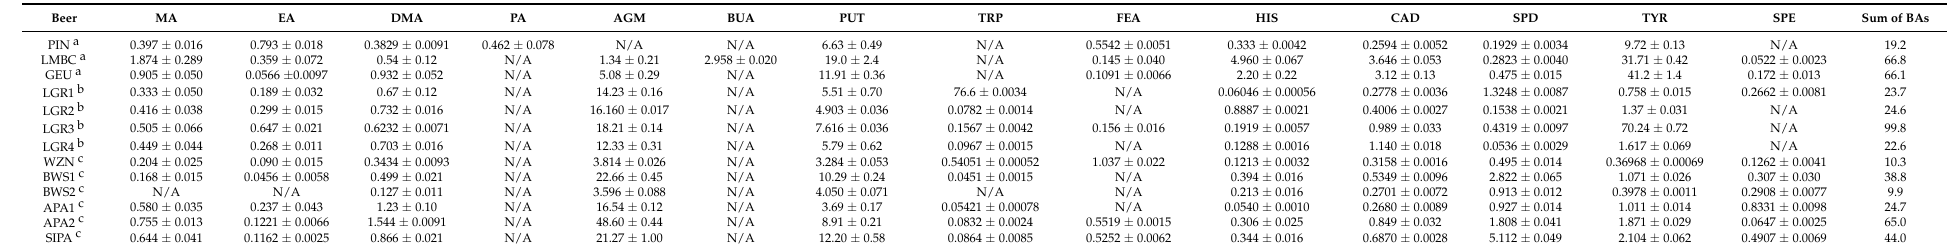
Table 3. Results of the determination of BAs in samples of commercially available beer (mg/L) ± sd ( n =